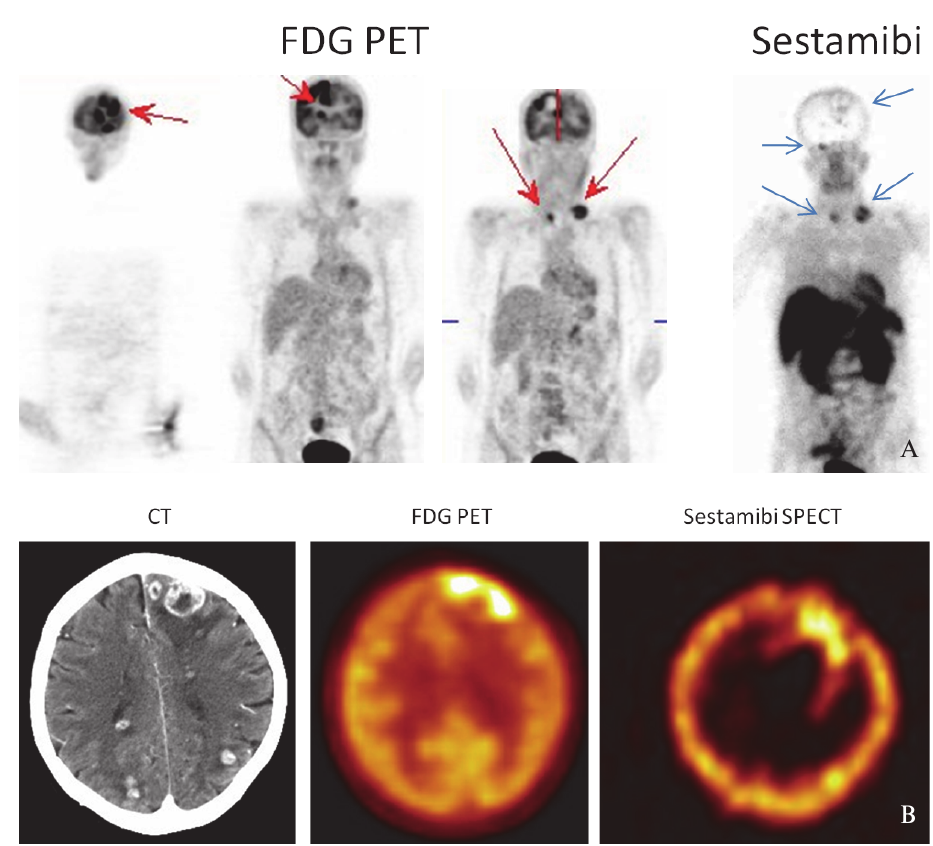
Fig. 4. Visualization of disease progression by [ 18 F] fluorodeoxyglucose positron-emission tomog- raphy and 99m technetium-sestamibi scan. FDG PET (A) in October 2008 revealed brain metastases, metastasis in the right orbit and the involvement of bilateral supraclavicular lymph nodes (red arrows). Similar findings were noted on 99m technetium-sestamibi scan (blue arrows). (B) CT (left), PET (middle) and 99m technetium-sestamibi SPECT (right) demonstrated metastatic lesions in the left